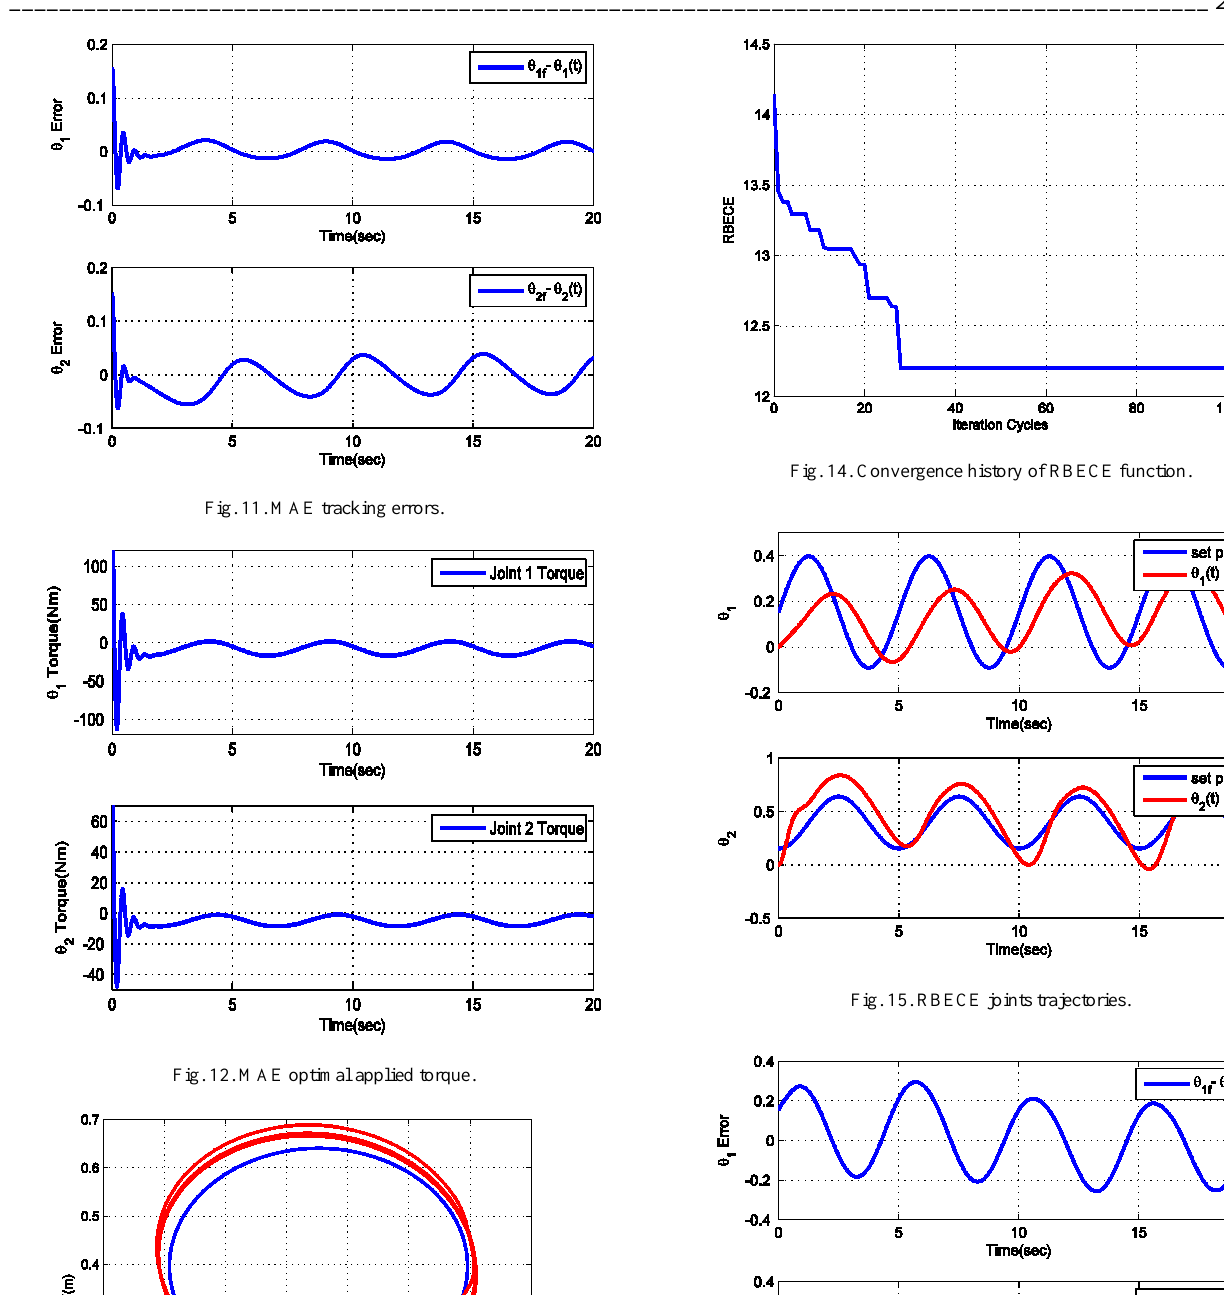
Fig. 12. MAE optimal applied torque.